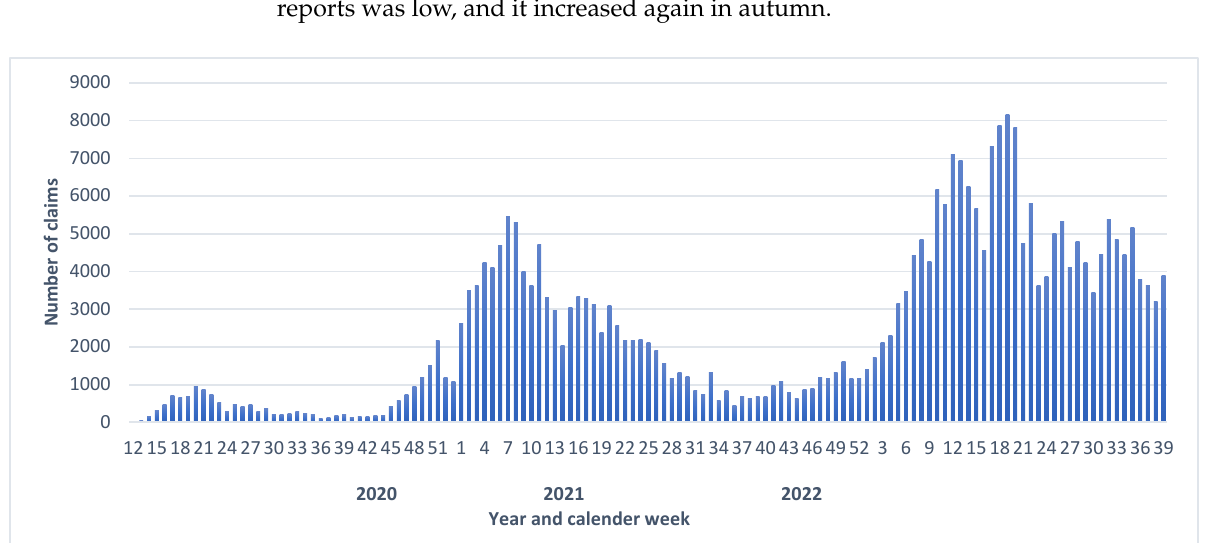
Figure 3. Proportion of cases (%) involving injury benefit among the reported cases in the respective calendar weeks of 2021.